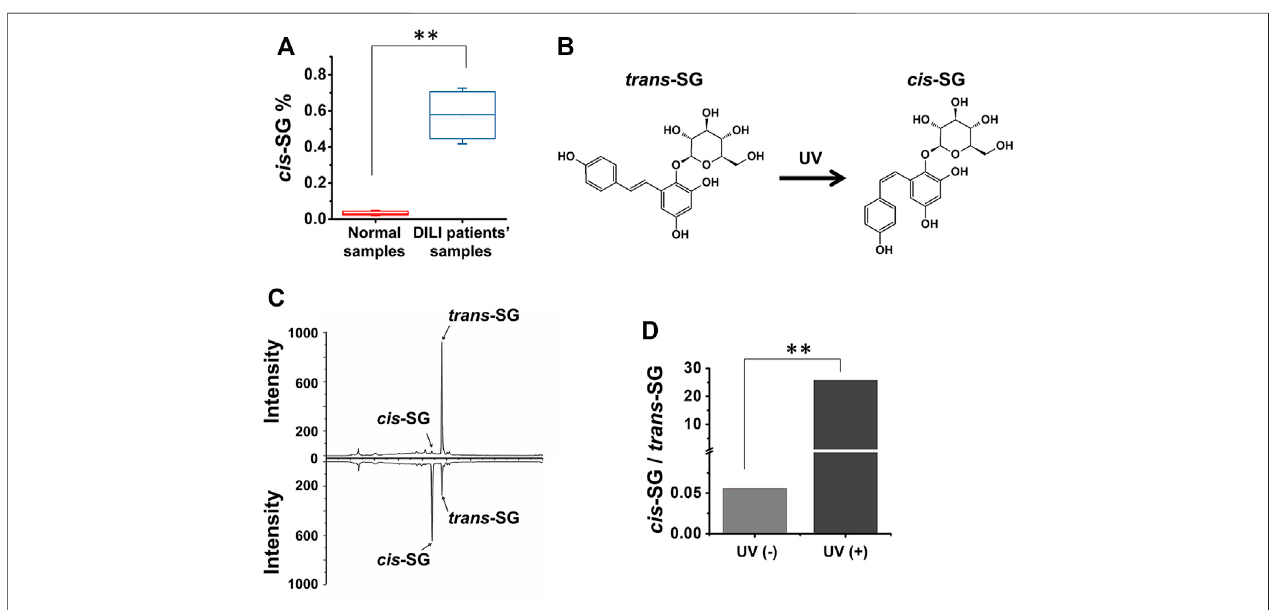
FIGURE 1 | Cis-SG in Polygonum multi fl orum – induced DILI patients ’ samples and its photoisomerization. (A) The content of cis-SG in normal Polygonum multi fl orum samplesandinsamplesfromDILIpatients. (B) Thechemical structure of trans-SG and cis-SG . (C) TheHPLCresults of trans-SG and cis-SG withoutorwith UV radiation. (D) The proportion of cis-SG to trans-SG without and with UV treatment. Values are expressed as mean ± SD. ** p < 0.01.